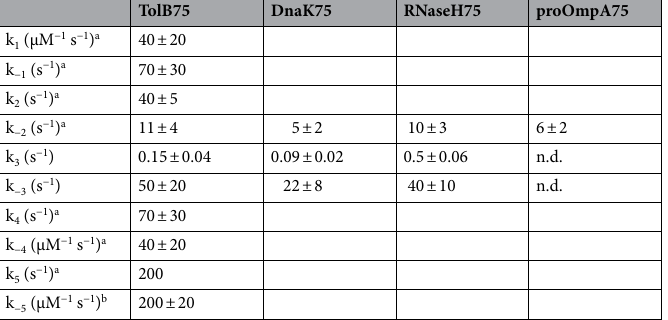
Table 3. Overview of globally fitted rate constants. Errors represent standard errors from global fit analysis or error margins determined from experiments ( a ). a Value fixed during fitting. b Value shared between all RNCs. n.d., not